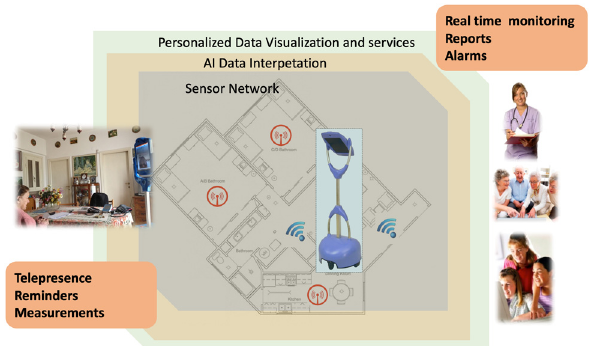
Figure 5: G IRAFF P LUS integrated